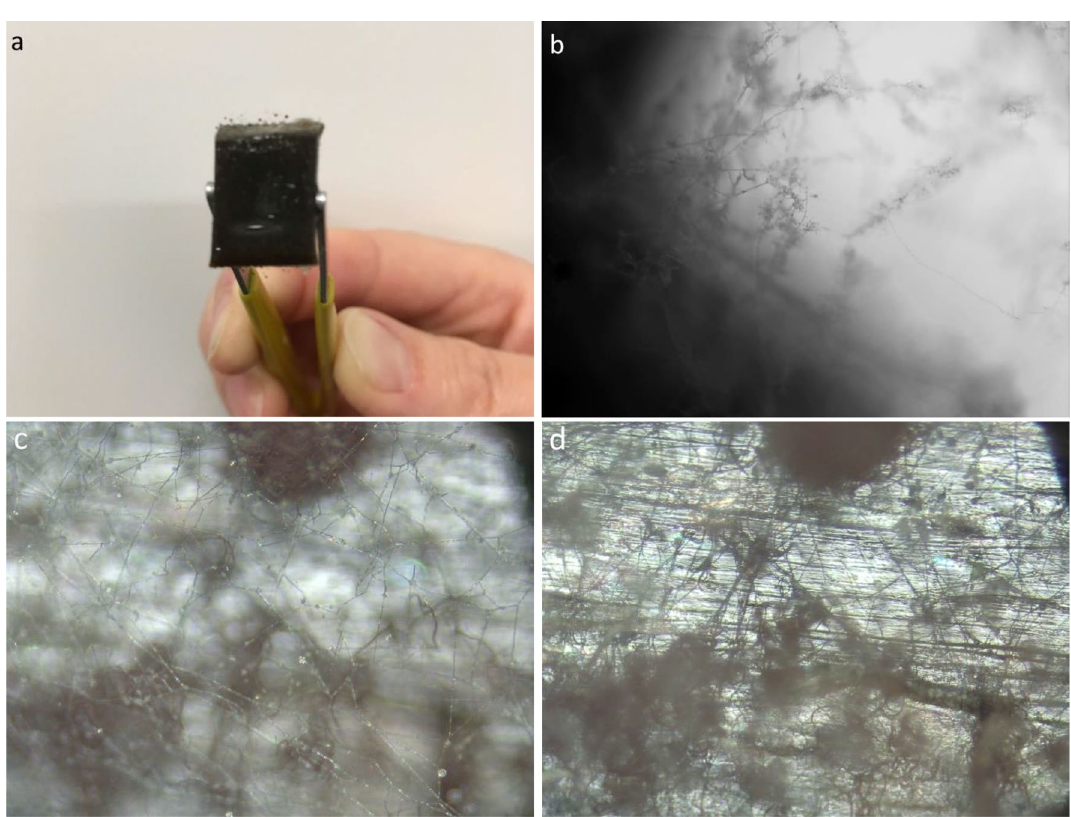
Figure 7. Mold visible on a sample of bio-PE composite with fiber and C1 ionic liquid; ( a ) view of the sample’s edge, ( b ) sample’s edge with the magnification of 100×, ( c ) a mesh of mold on sample’s surface. magnification 50×, ( d ) surface of the sample under the mold. magnification